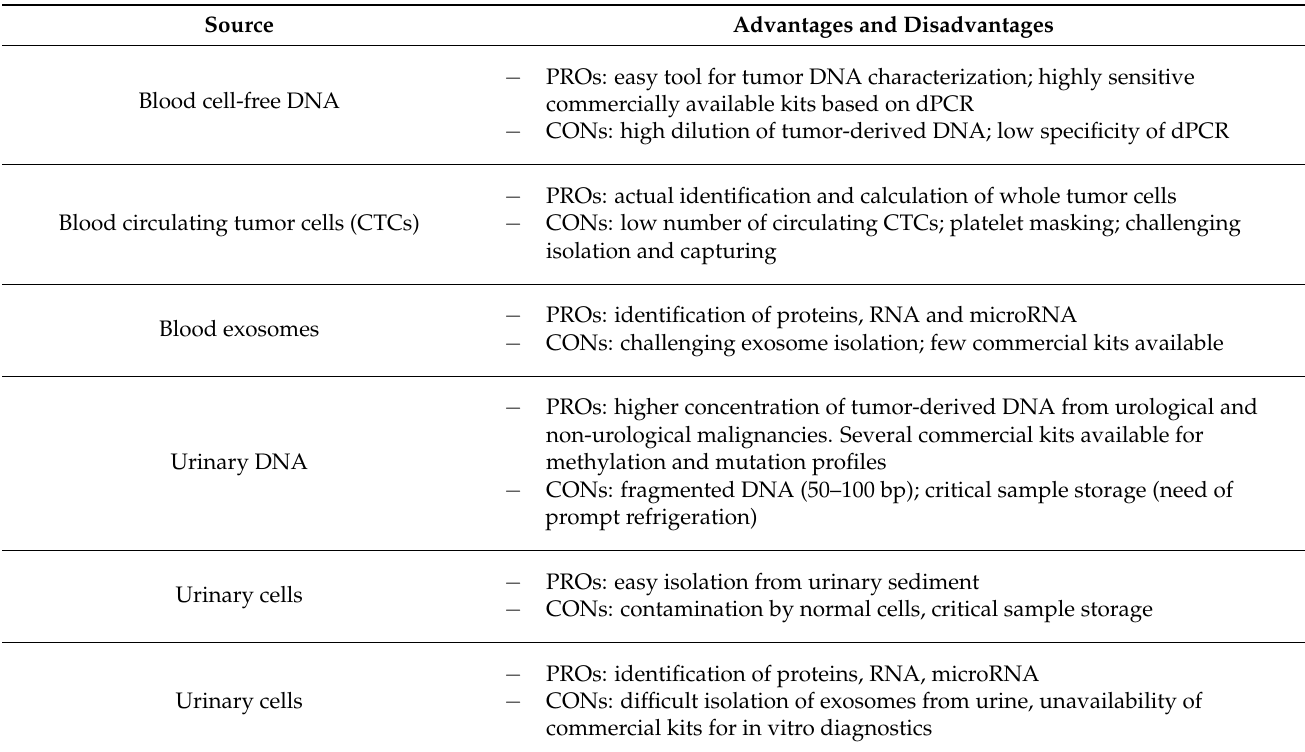
Table 1. Characteristics of sources of biomarkers in liquid biopsies [1]. Source Advantages and Disadvantages Blood cell-free